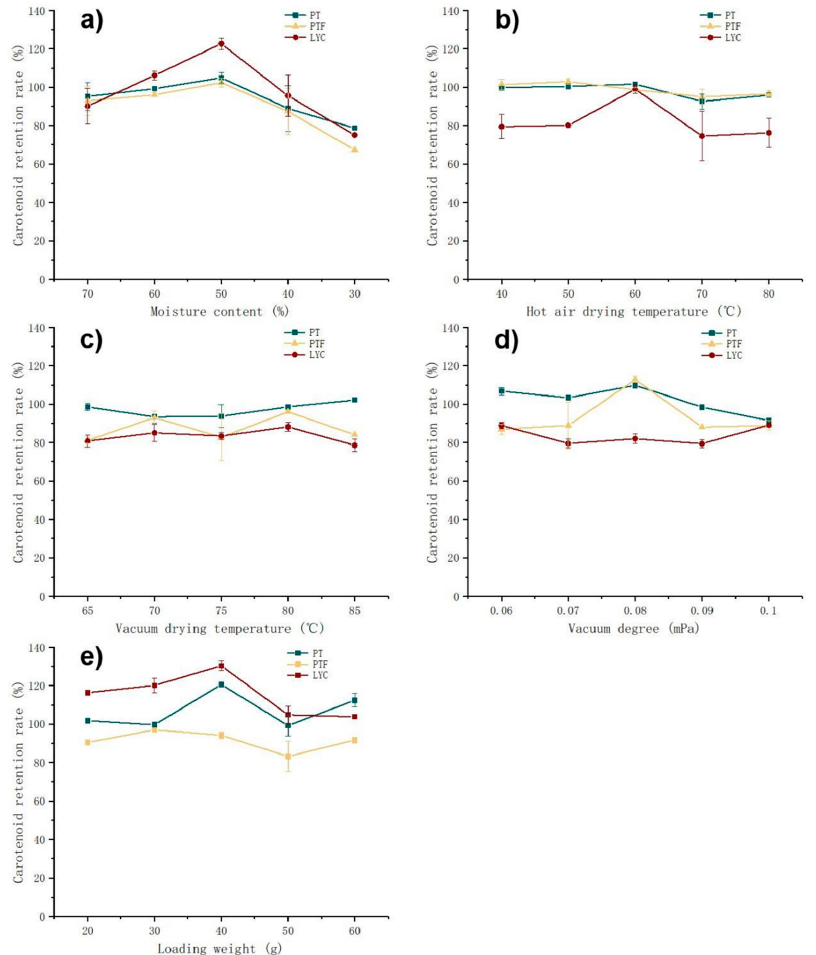
Figure 6. The influence of changeover water content, HAD temperature, VD temperature, VD vacuum and loading weight on retention rates is shown in ( a – e ), respectively. Besides the parameters explored, other parameters were as follows: ( a ) HAD temperature 60 °C, VD temperature 80 °C, VD vacuum 0.1 mPa and loading weight 30 g; ( b ) MTP 50%, VD temperature 80 °C, VD vacuum 0.1 mPa and loading weight 30 g; ( c ) changeover water content 50%, HAD temperature 60 °C, VD vacuum 0.1 mPa and loading weight 30 g; ( d ) changeover water content 50%, HAD temperature 60 °C, VD temperature 80 °C and loading weight 30 g; ( e ) changeover water content 50%, HAD temperature 60 °C, VD temperature 80 °C and VD vacuum 0.08 mPa. The raw material was the mixed tomato pulp of five tomato varieties selected. The retention rate was obtained by comparing tomato powder with tomato pulp material (preheated in a 60 °C water bath for 10 min).